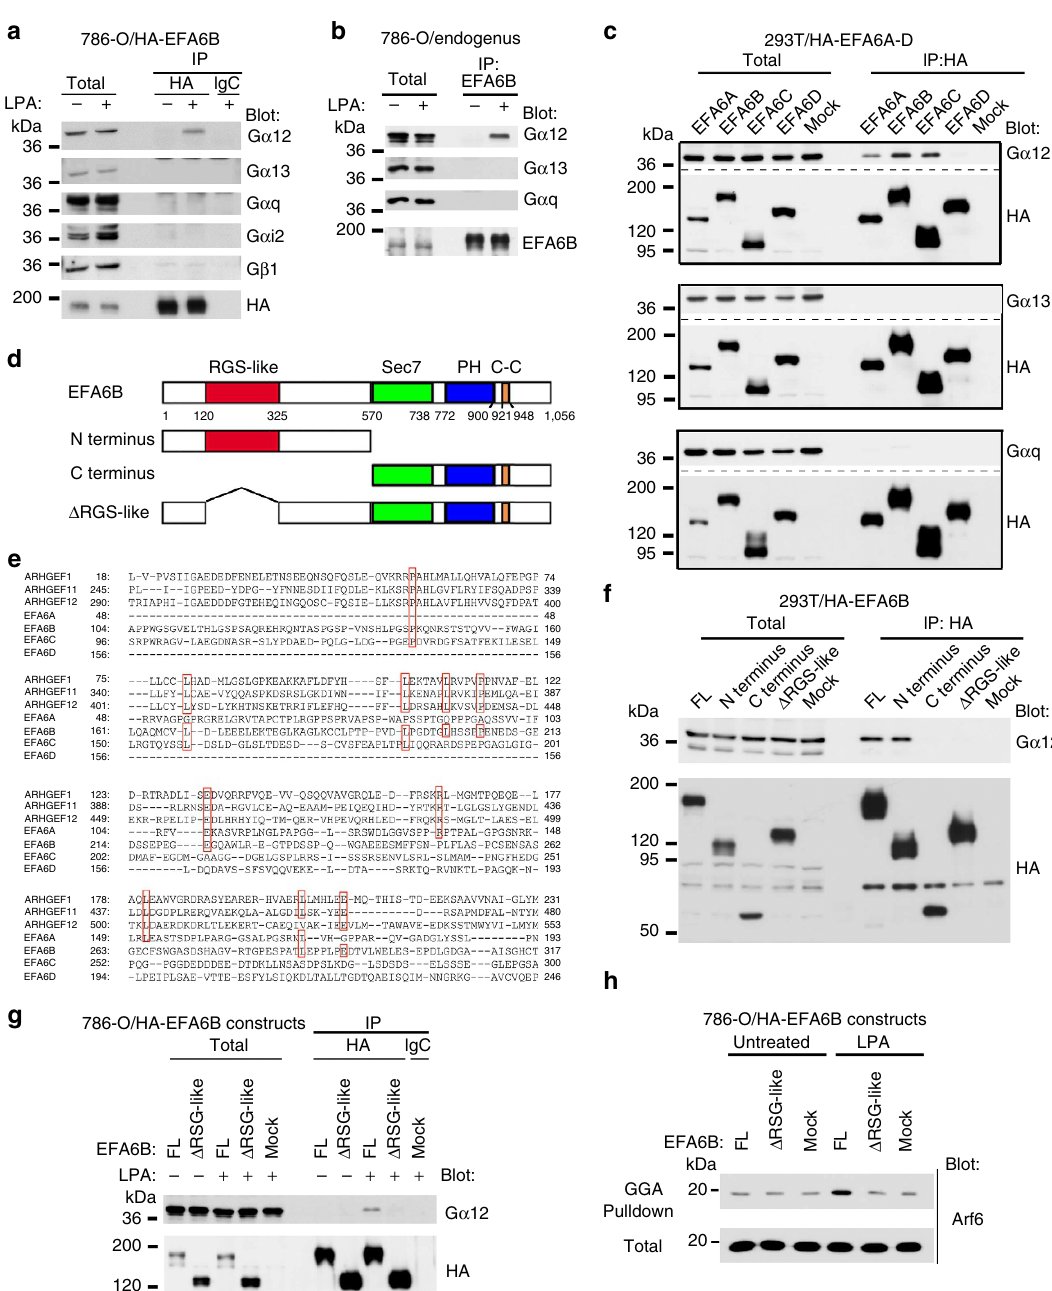
Figure 5 | GTP-G a 12 bind to EFA6A-C but not to EFA6D to activate Arf6. ( a ) Binding of HA-EFA6B with G a 12 on LPA stimulation. EFA6B/shEFA6B cells (786-O/HA-EFA6B) were either stimulated with LPA or left untreated for 5min, and the co-precipitation of endogenous trimeric G-proteins with HA-EFA6B was then analysed by anti-HA immunoprecipitation (IP) coupled with immunoblotting using the indicated antibodies. An irrelevant mouse IgG (IgG) was used as a control. ( b ) Endogenous association of G a 12 with EFA6B. Co-precipitation of G a 12, but not G a 13 or G a q, with anti-EFA6B immunoprecipitants (IP) of 786-O cell lysates was examined, coupled with immunoblotting as indicated. ( c ) EFA6A-C, but not EFA6D, binds to GTP-G a 12. 293T cells were transfected with plasmids encoding HA-EFA6A-D or with an empty vector (Mock), together with plasmids encoding G a 12QL, G a 13QL, or G a qQL; and co-precipitation of these G-proteins with EFA6 family members was assessed as in a . ( d ) Schematic representation of the domain structure of EFA6B and its mutants. ( e ) The primary structures of the RGS domains of RhoGEFs, ARHGEF1, ARHGEF11, and ARHGEF12, and their amino acid alignment with the N-terminal regions of EFA6A-D. Conserved amino acids are marked in red boxes. ( f ) The RSG-like domain is essential for the binding to GTP-G a 12. Full-length HA-EFA6B (FL) and its mutants were expressed in 293T cells together with G a 12QL, as indicated, and their co-precipitation was assessed as in a . An empty vector (Mock) was included as a control. ( g , h ) Requirement for the RSG-like domain in the binding to endogenous G a 12 and the activation of Arf6. Full-length HA-EFA6B (FL) and its D RGS-like mutant were expressed in 786-O cells, in which endogenous EFA6B was silenced; and co-precipitation of HA-EFA6B proteins with G a 12 ( g ) and activation of Arf6 ( h ) were examined on LPA stimulation. ( a – c , f – h ) Total, total cell